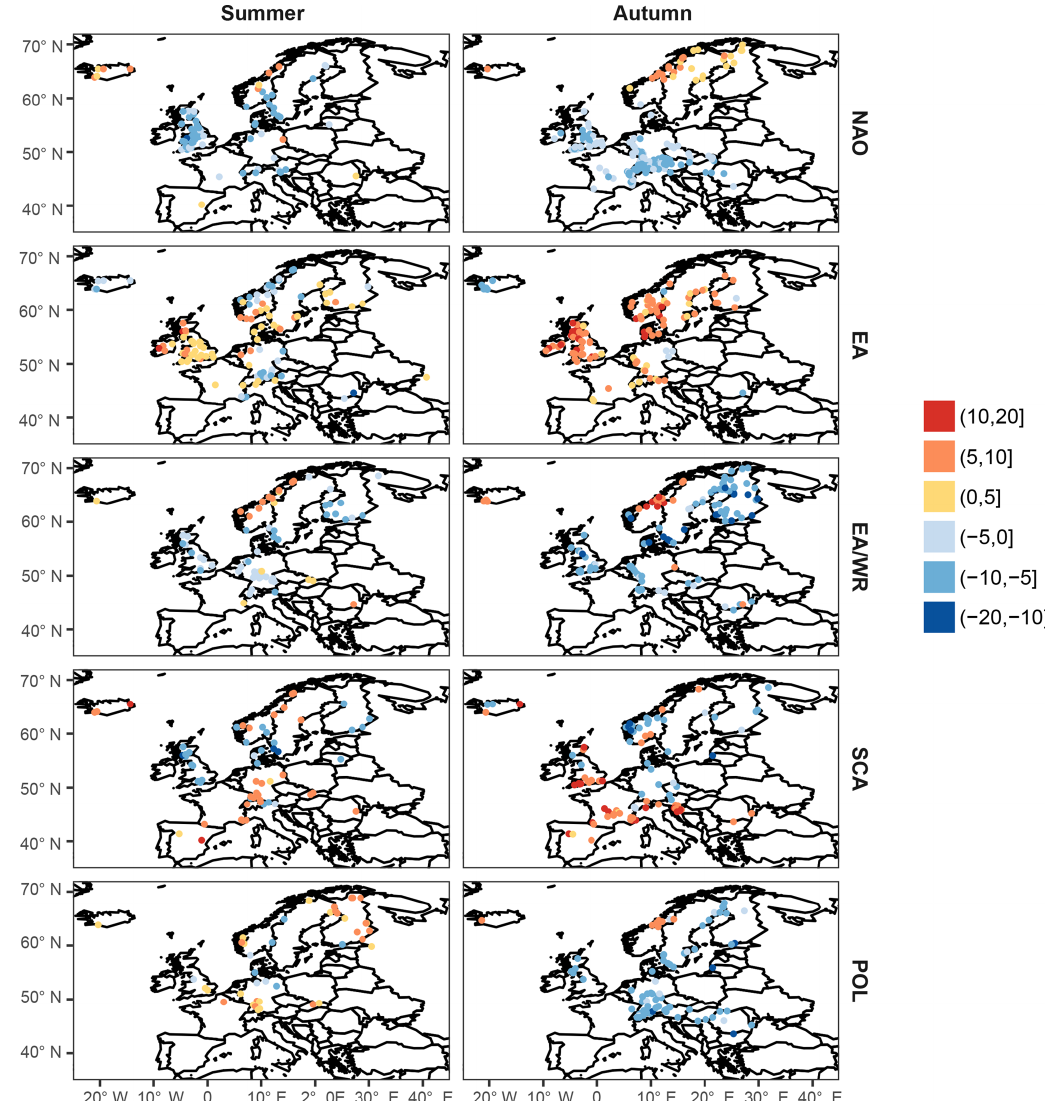
Figure 6. Same as Fig. 5 but for the summer and autumn